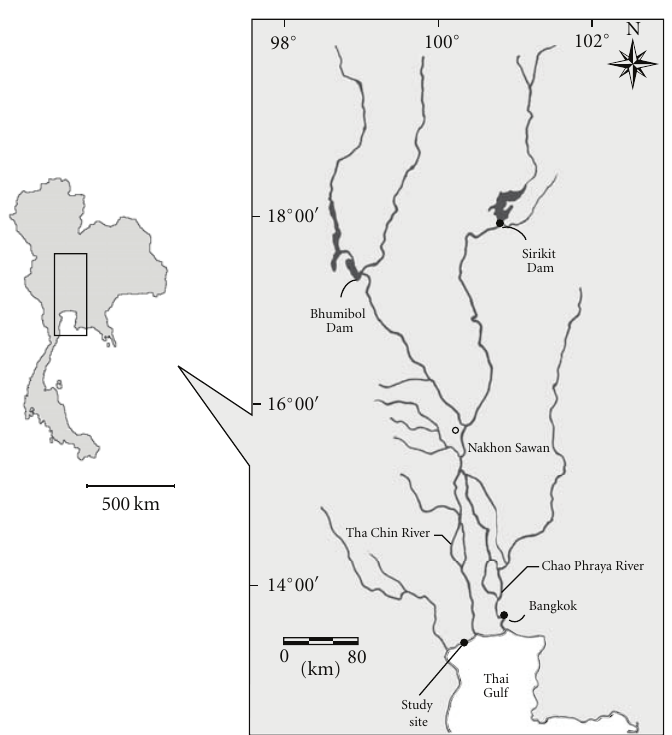
Figure 1: Location of the study site. Samut Sakhon province, Thailand.